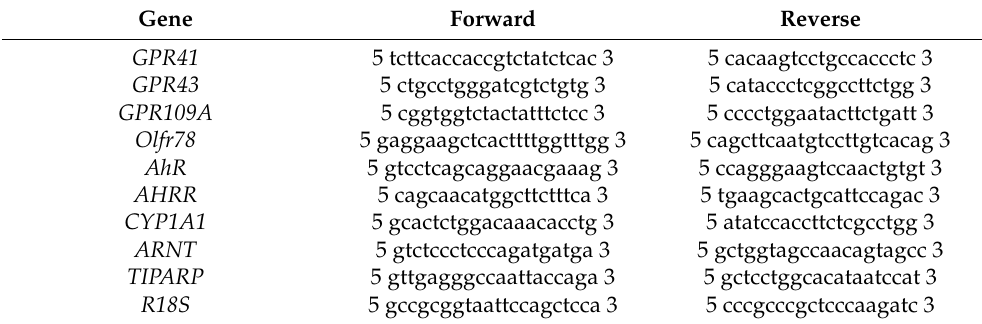
Table 1. PCR primer